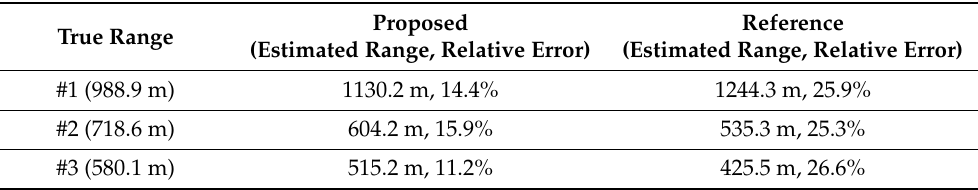
Table 2. The range estimates and relative errors of the proposed and reference methods at different ranges in the